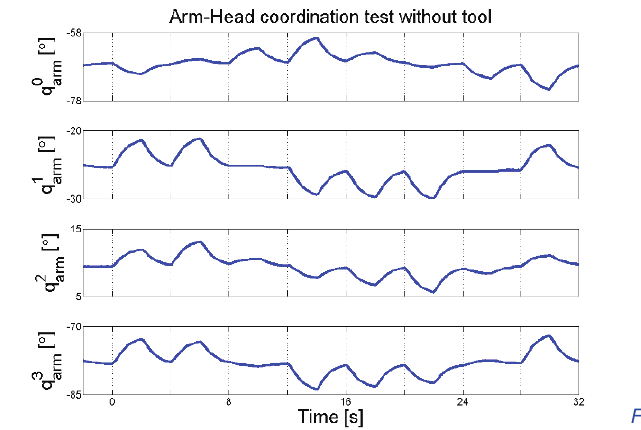
Figure 22. End-e(cid:636)ector visual trajectory in the image plane during the STAR test performed with the tool.